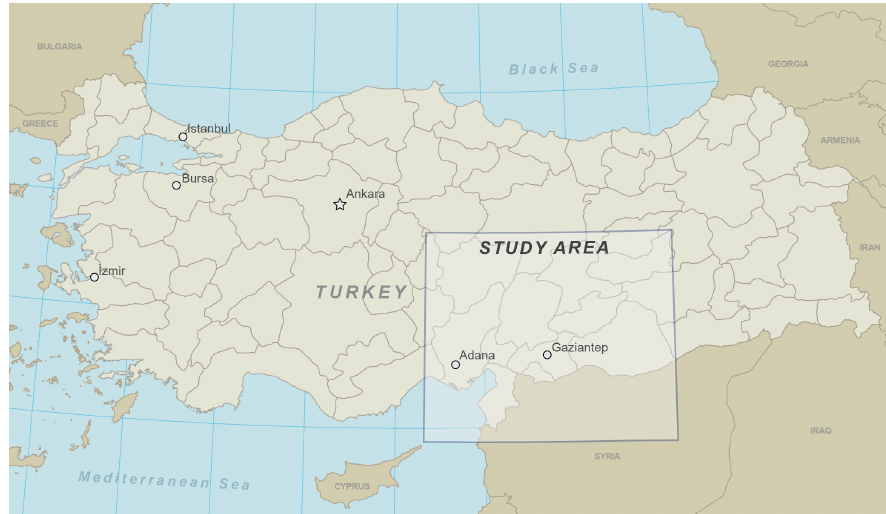
Figure 1. Study area within southeastern Turkey.